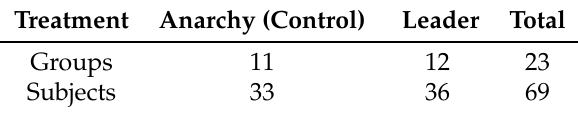
Table 1. Number of independent groups and subjects per treatment.